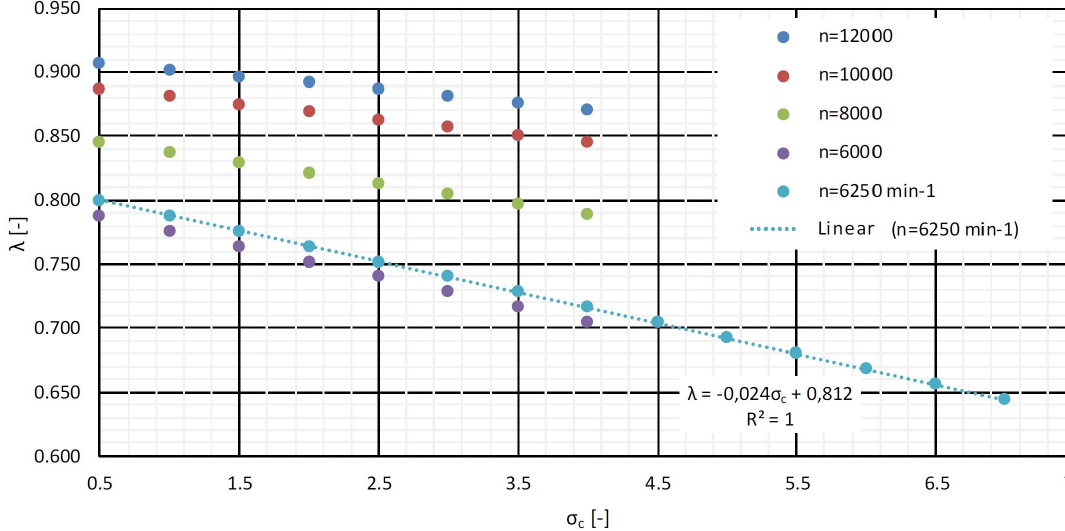
Figure 2: Dependence λ on speed and total pressure ratio